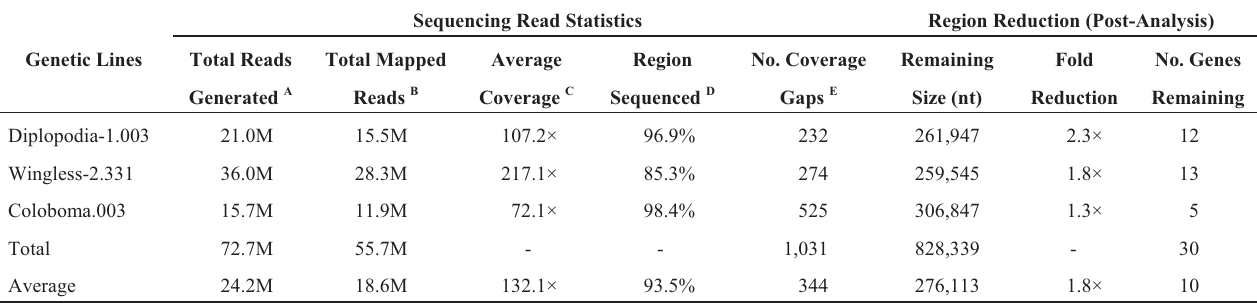
Table 2. Summary of targeted genomic enrichment sequencing results for three developmental mutant congenic lines.